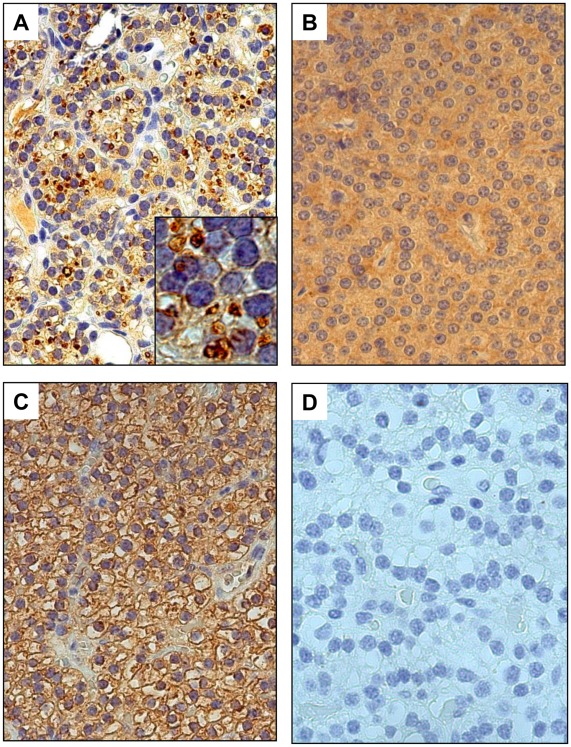
Immunohistochemical analysis of PRLr expression using the PRLrI antibody. The photomicrographs show parathyroid tumour tissues (A–C) and negative control (D). Parathyroid tumours are shown with immunostaining of cytoplasmic granulae and cytoplasm (A), of cytoplasm only (B), and of cell membrane and cytoplasm (C).